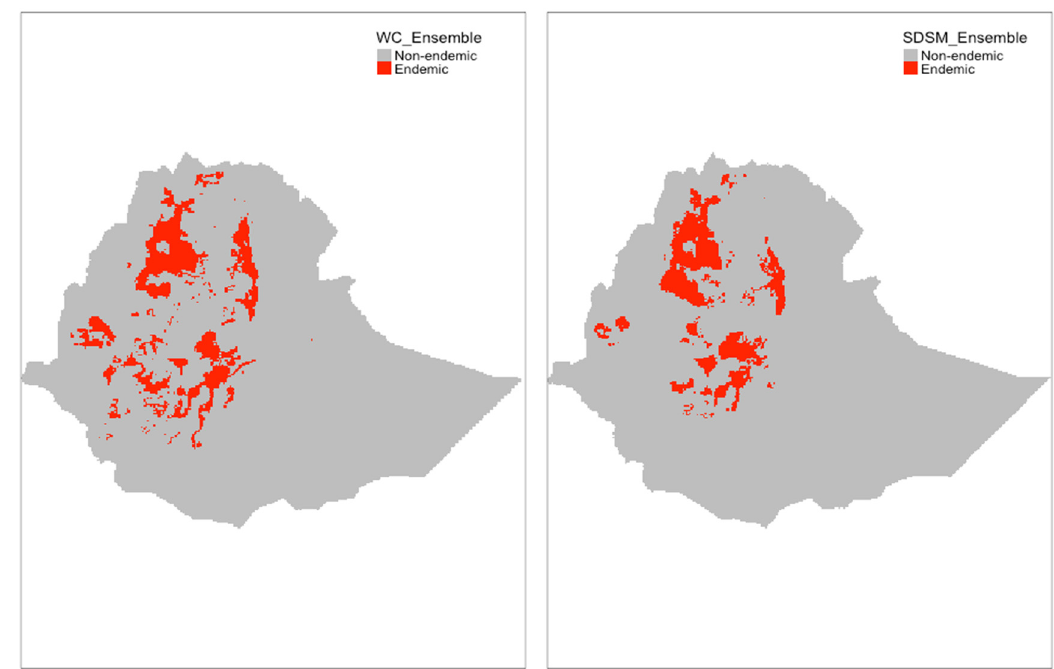
Figure 5. Distribution of S. mansoni endemic areas in Ethiopia projected by WC-based ( left ) and SDSM-based ( right ) ensemble models. An area is ‘endemic’ if the model-predicted probability of presence is ≥ 0.65 and considered ‘nonendemic’ otherwise. The threshold was chosen to maximize balance accuracy based on the ground-truthing data.